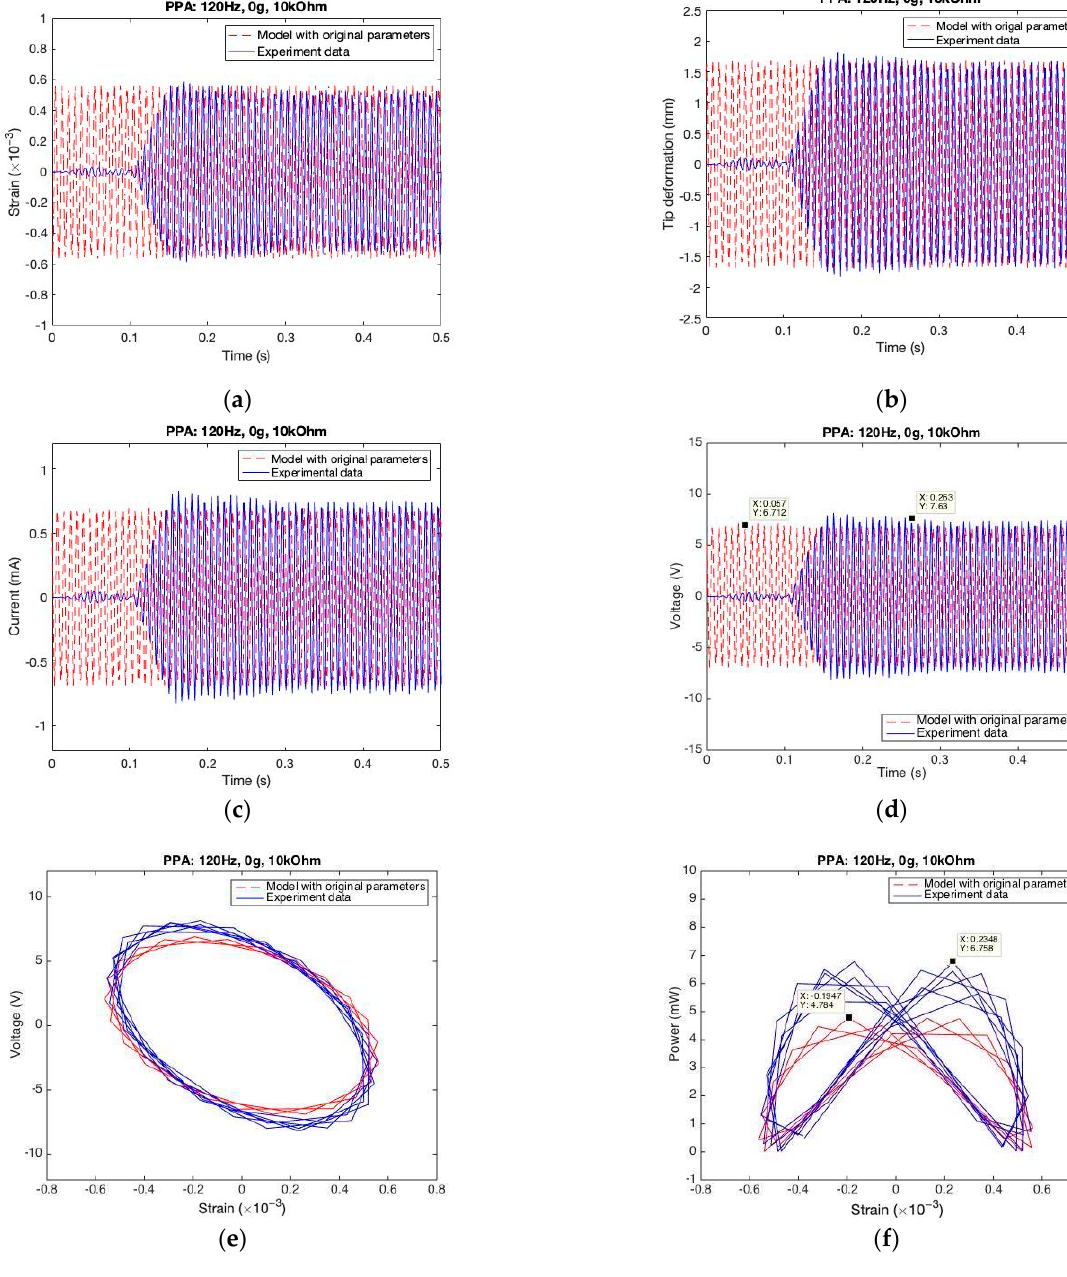
Figure 13. Comparison between the experimental and the model simulation results with original parameters in the PPA. ( a ) Strain vs. time; ( b ) Deformation vs. time; ( c ) Current vs. time; ( d ) Voltage vs. time; ( e ) Voltage vs. strain; ( f ) Power vs. strain.